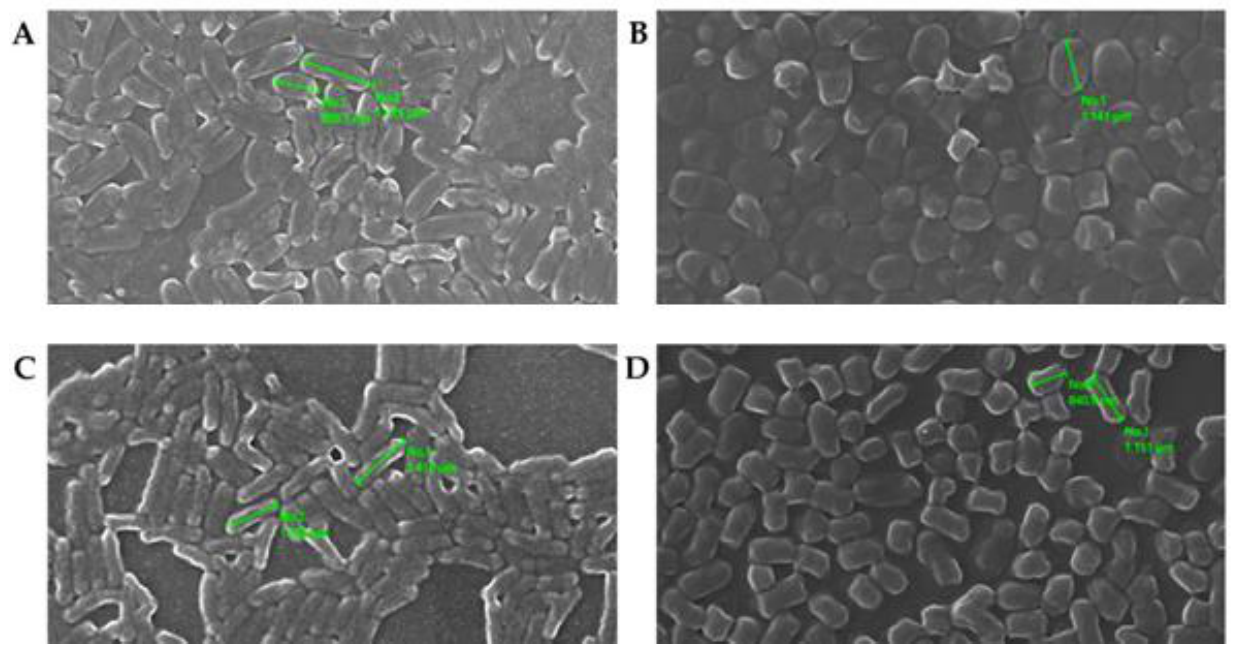
Figure 3. SEM analysis (10,000×) of 13a and SC5II before ( A , B , respectively) and after absorption of copper(II) ( C , D ). copper(II) ( C , D